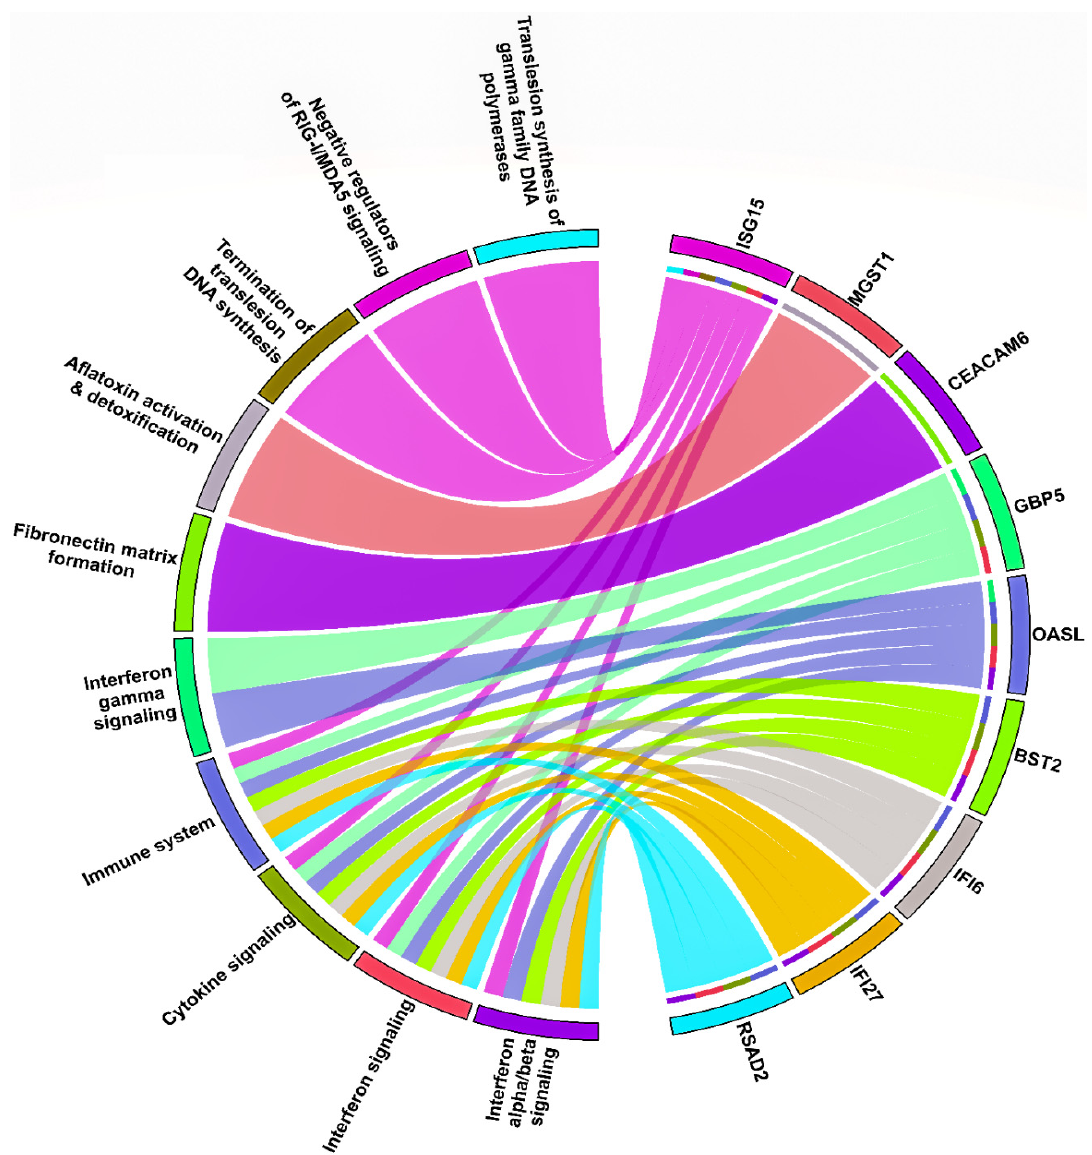
Figure 6. Chord plot showing the association of the top 10 significant pathways and nine DEGs involved in them. The outer circle indicates the top 10 pathways (on the left semicircle) and nine DEGs (on the right semicircle). Each DEG has a unique color band, and the undirected colored edge inside the circle represents the relationship of a particular DEG with the respective connected pathway(s).